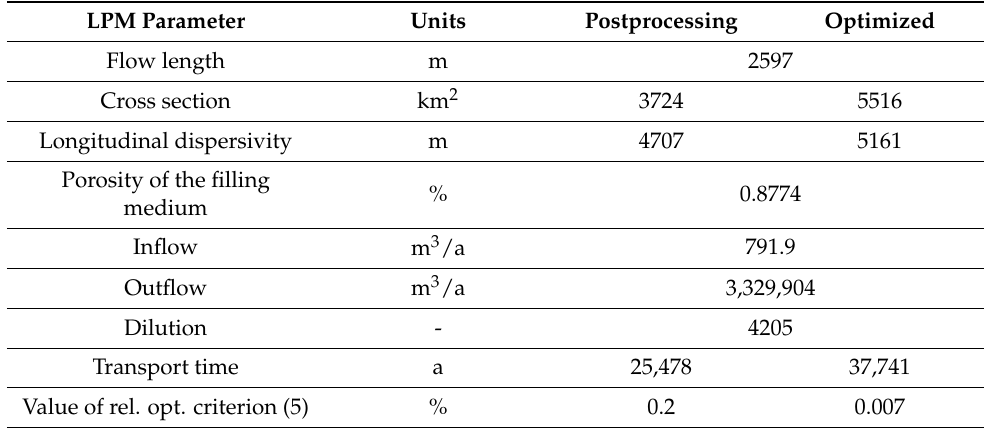
Table 2. Parameters obtained by the postprocessing and by the optimization used to set one “Pipe” component. The last row represents the evaluation of fit between the LPM and the 3D model. LPM